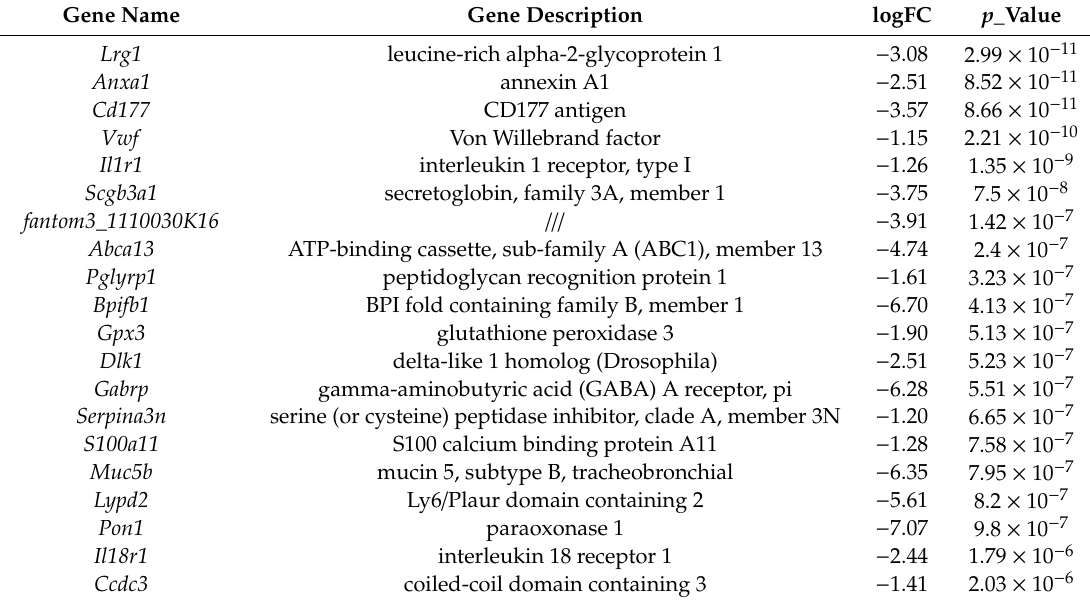
Table 3. Top 20 genes downregulated in Se-Met-treated 3 × Tg-AD mice versus 3 × Tg-AD